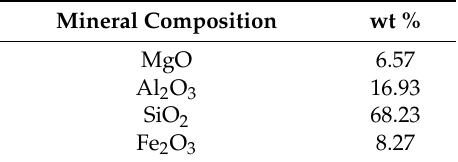
Table 1. Composition of the red pottery clay used in this study. Mineral